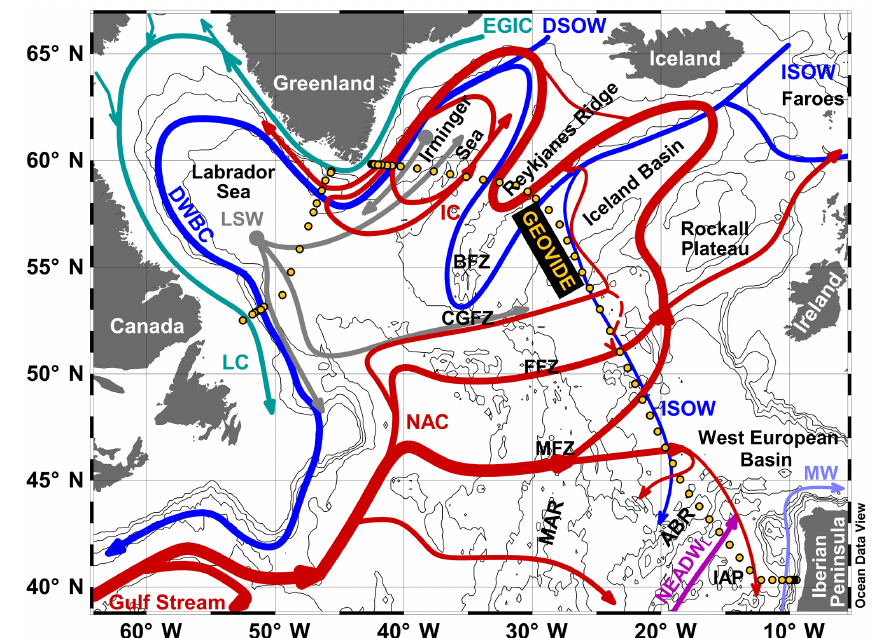
Figure 1. Schematic diagram of the large-scale circulation in the subpolar North Atlantic adapted from Daniault et al. (2016). Isobaths every 1000dbar are represented by black contours. GEOVIDE (GEOTRACES-GA01 section) hydrographic stations are indicated by yellow dots. The main topographical features are labelled as follows: Azores–Biscay Rise (ABR), Bight Fracture Zone (BFZ), Charlie–Gibbs Fracture Zone (CGFZ), Faraday Fracture Zone (FFZ), Iberian Abyssal Plain (IAP), Maxwell Fracture Zone (MFZ) and Mid-Atlantic Ridge (MAR). The main water masses and currents are also represented: Denmark Strait Overflow Water (DSOW), Deep Western Boundary Current (DWBC), East Greenland Irminger Current (EGIC), Iceland–Scotland Overflow Water (ISOW), Irminger Current (IC), Labrador Current (LC), Labrador Sea Water (LSW), Mediterranean Water (MW), North Atlantic Current (NAC) and North-East Atlantic Deep Water lower (NEADW L )